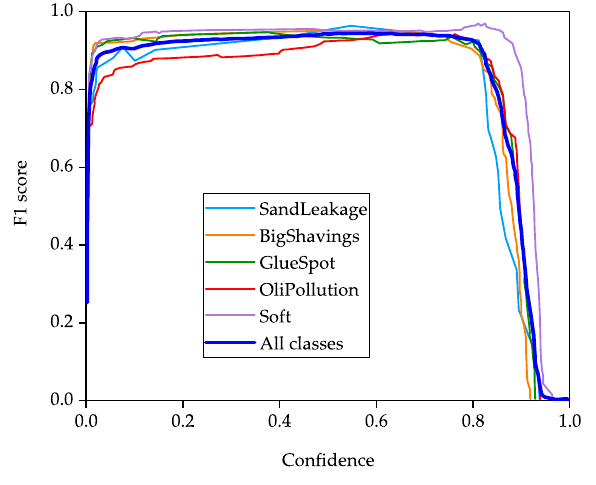
Figure 7. F1 score